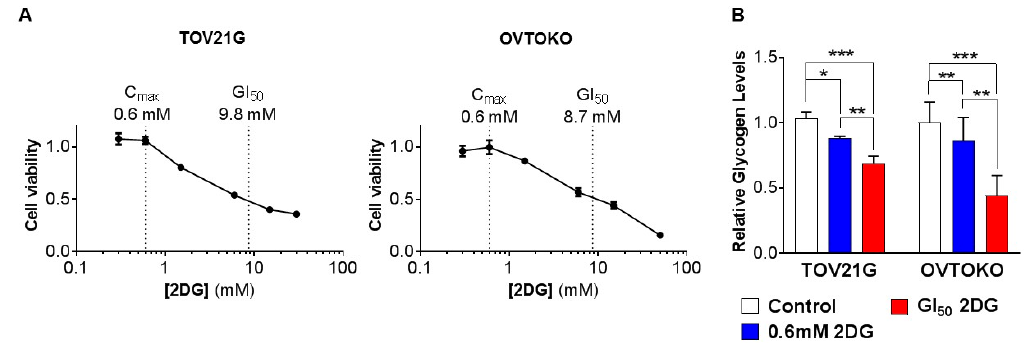
Figure 1. Effect of 2-deoxy-D-glucose (2DG) on in vitro growth of ovarian clear cell carcinoma (OCC) cell lines with distinct chemo-sensitivities. TOV21G and OVTOKO cells were treated with increasing concentrations of 2DG (TOV21G cells 0-30 mM; OVTOKO cells 0–50 mM) for 72 h. ( A ) Cell viability was quantified using a CellTiter assay kit and a PHERAstar Omega plate reader. The calculated GI 50 value for each line is shown as well as an average of the 2DG C max value achieved in cancer patients [1,2]. ( B ) Graphs of relative glycogen levels quantified from cells collected after a 72 h treatment period. Results are presented as mean +/- SEM from triplicates of three independent assays. *, P ≤ 0.05; **, P ≤ 0.01; ***, P ≤ 0.001 .